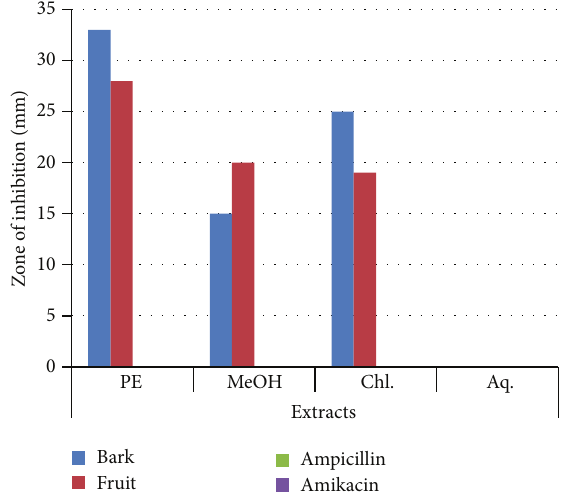
Figure 6: Zone of inhibition produced by different part of C. ambrosioides against B. subtilis .